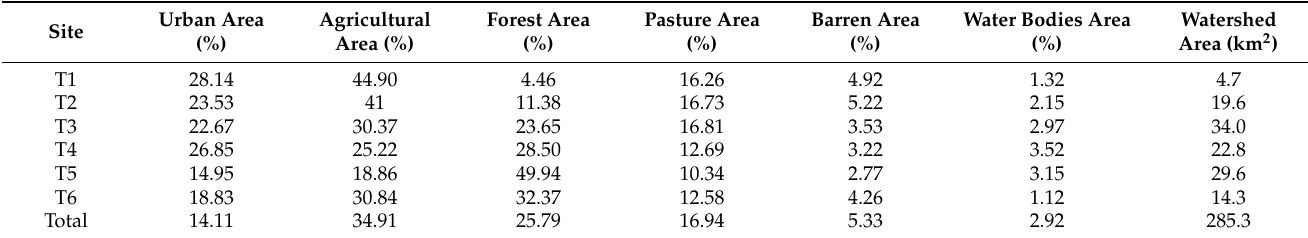
Table 2. Land use and land cover of the Miho upstream